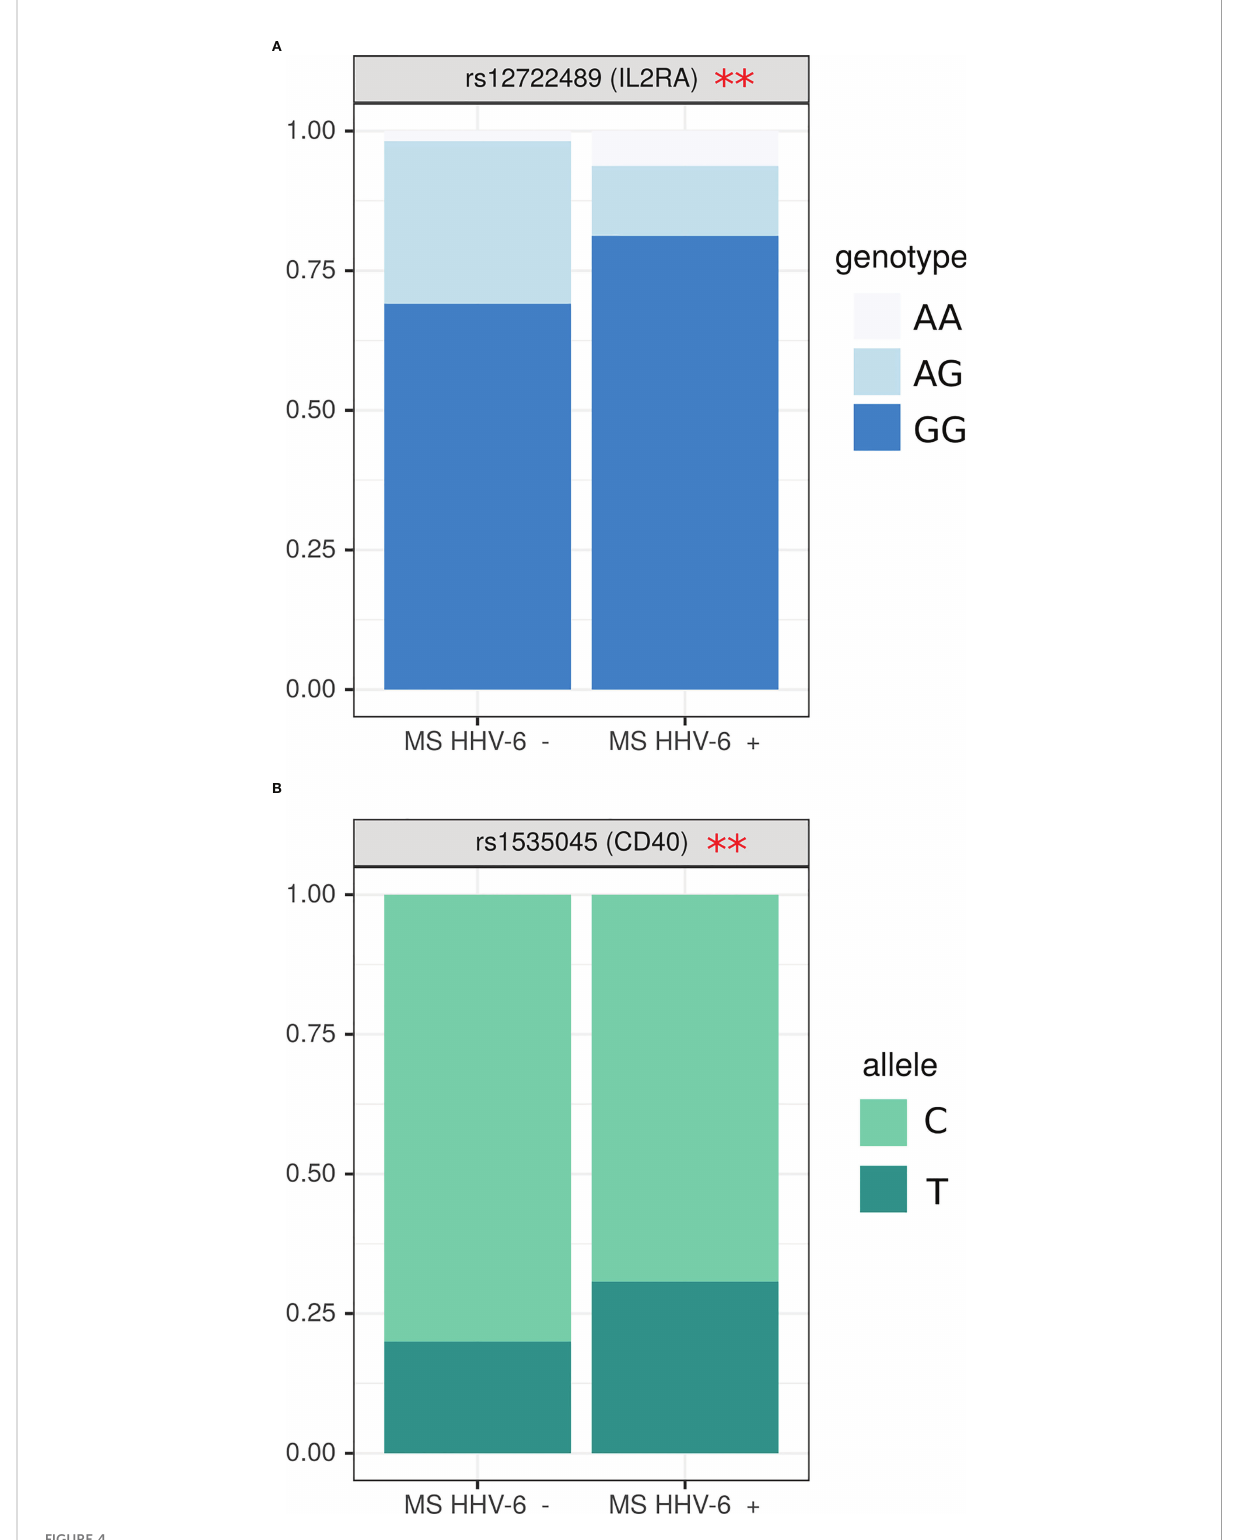
FIGURE 4 Analysis of SNPs genotype and allele frequency based on detection of circulating anti-HHV6 antibodies. (A) genotypes, (B) alleles. Data is presented as proportion of representation of genotype/allele. There were 151 MS patient samples used for the analysis. The analysis was done using Fisher ’ s exact test. ** -